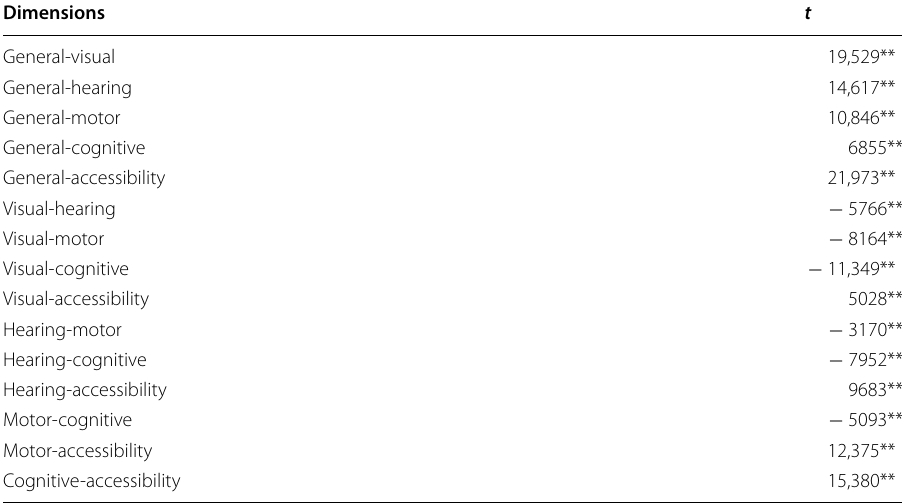
Table 4 Student t ‑value between the different dimensions of the questionnaire